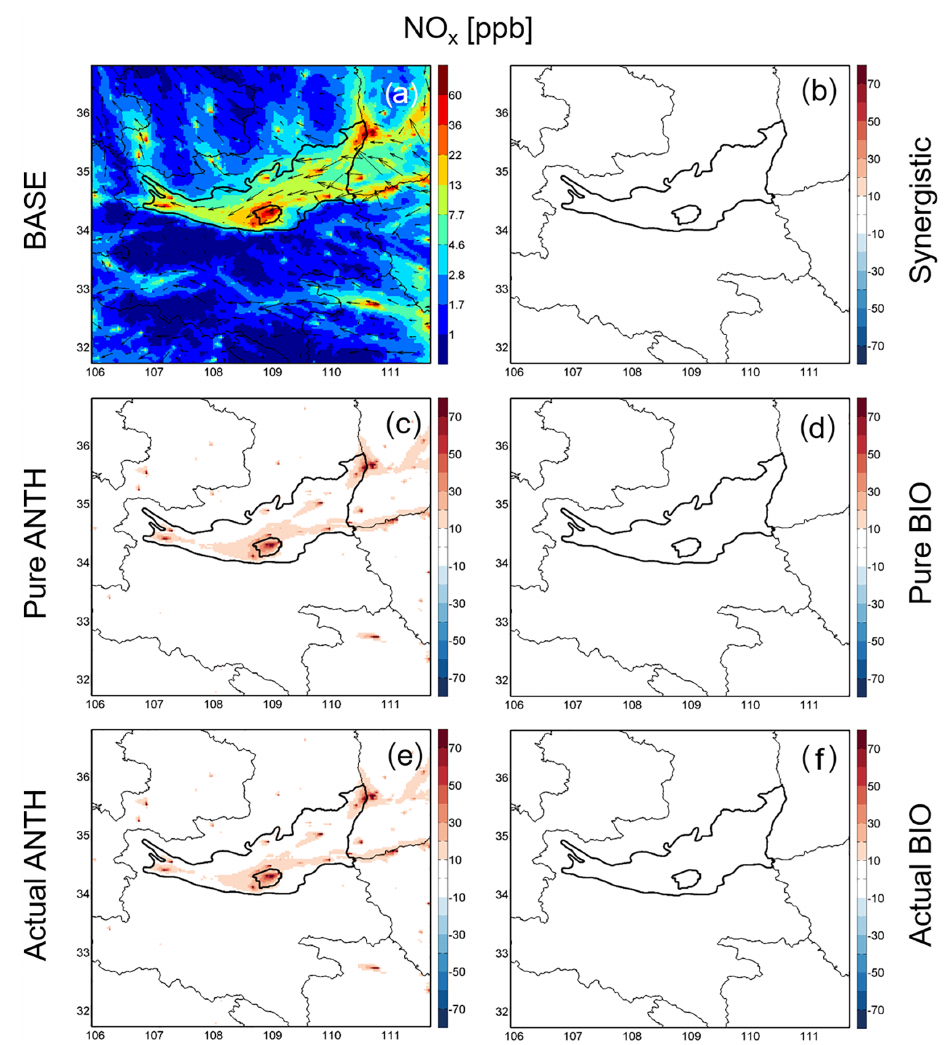
Figure 5. Spatial distributions of monthly mean concentrations of NO x in August 2011. Panel (a) is the result from the BASE simula- tion, overlaid with simulated wind vectors. Panels (b–f) are simulated NO x concentrations contributed from synergistic anthropogenic and biogenic, pure anthropogenic, pure biogenic, actual anthropogenic and actual biogenic sources, respectively.